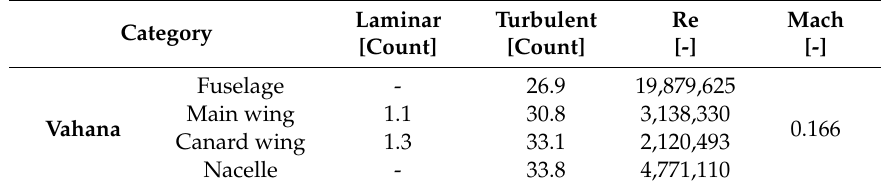
Table 6. Flat-plate skin friction coe ffi cient of Vahana.